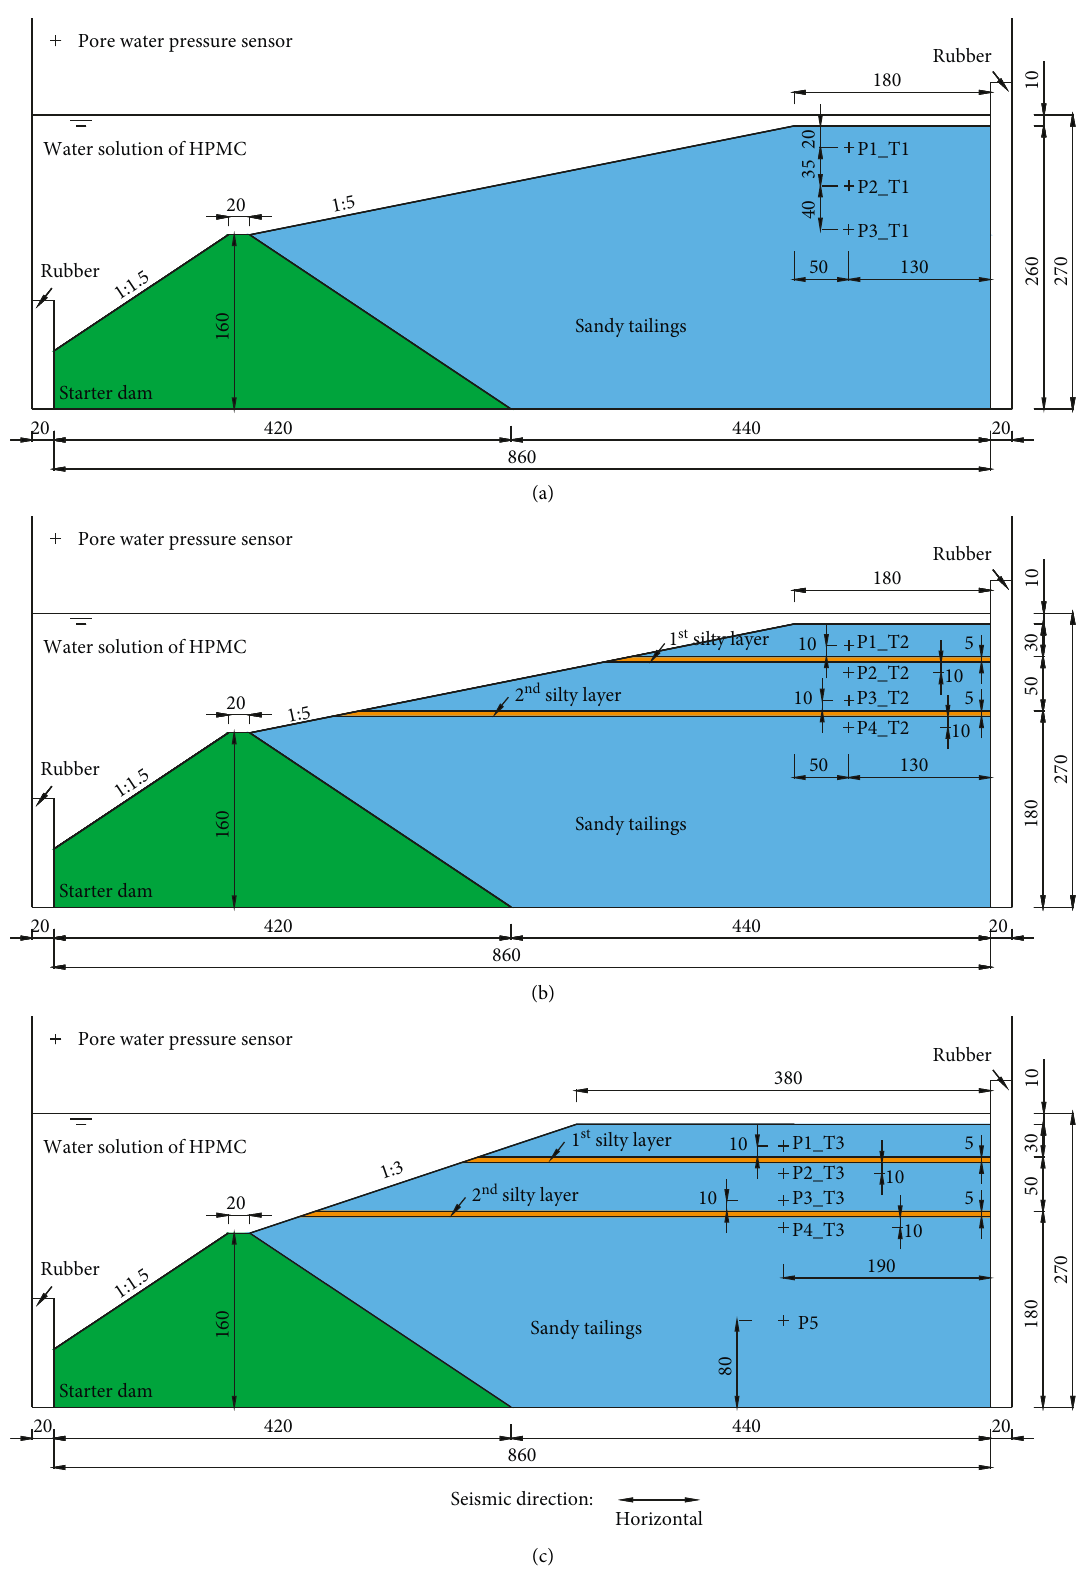
Figure 2: Schematic drawings of the models in tests: (a) T 1, (b) T 2, and (c) T